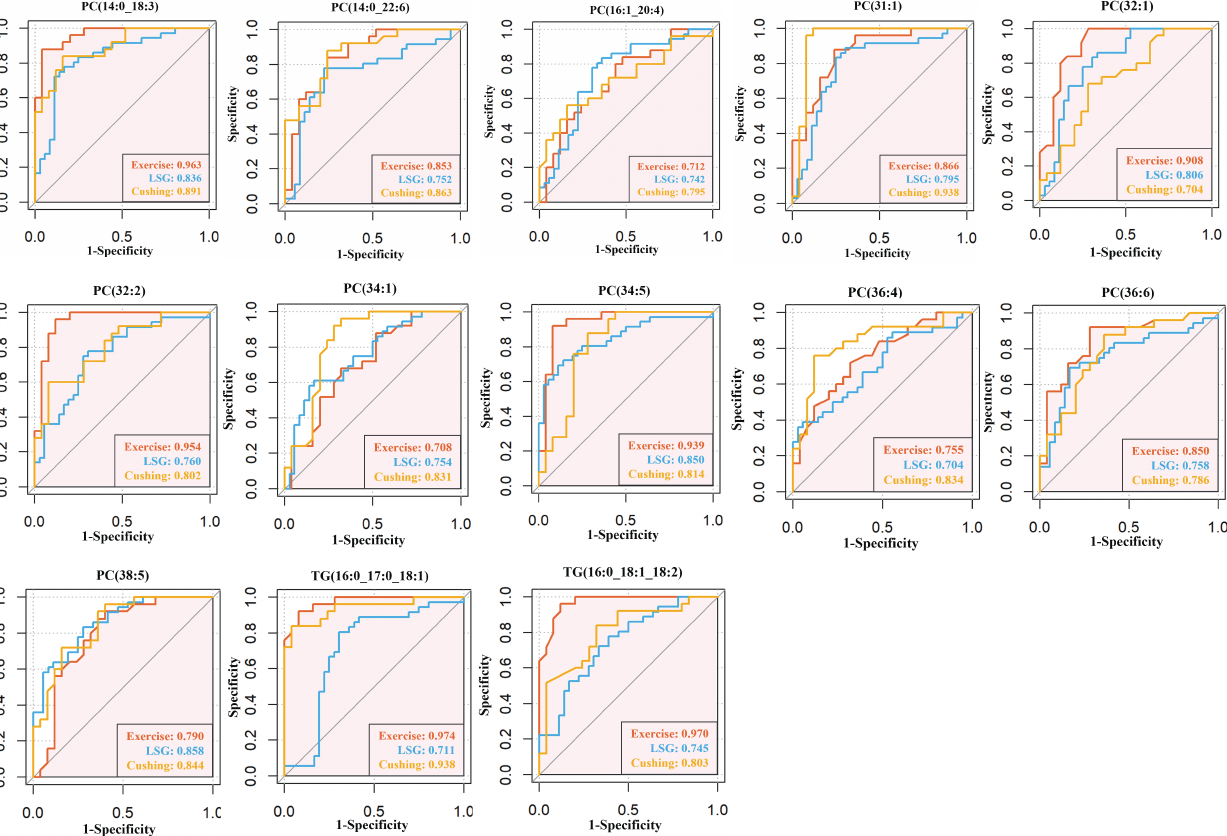
Figure 7. The ROC curves of predictive models generated by lipid species. AUC scores of ROC curves are listed on the right of the prediction